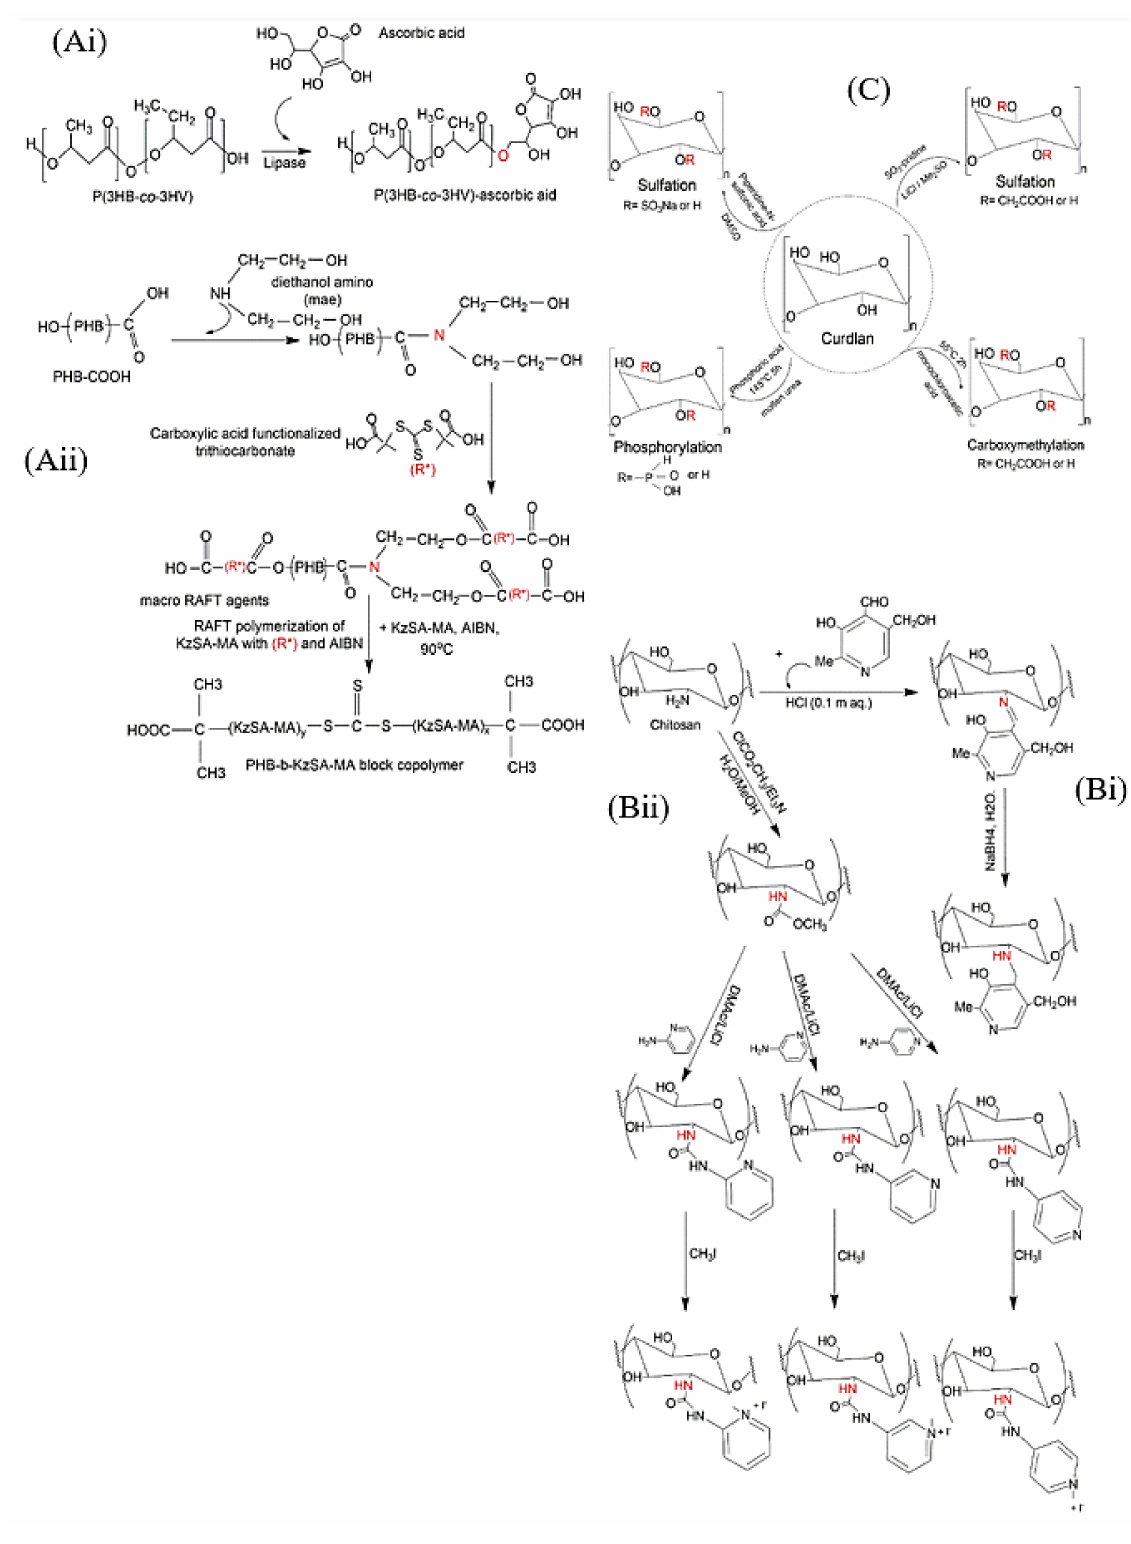
Figure 5. Chemical illustration of post-synthetic modification of three natural polymers, Enzyme mediated modification of P(3HB-co-3HV) ( Ai ), Biobased block copolymer synthesis using a novel methacrylated methyl salicylate and PHB ( Aii ), Cs pyridoxal derivatives are synthesized ( Bi ), Syn- thetic strategy of the novel pyridylurea-functionalized Cs derivatives ( Bii ) and Curdlan non-selective modification techniques ( C